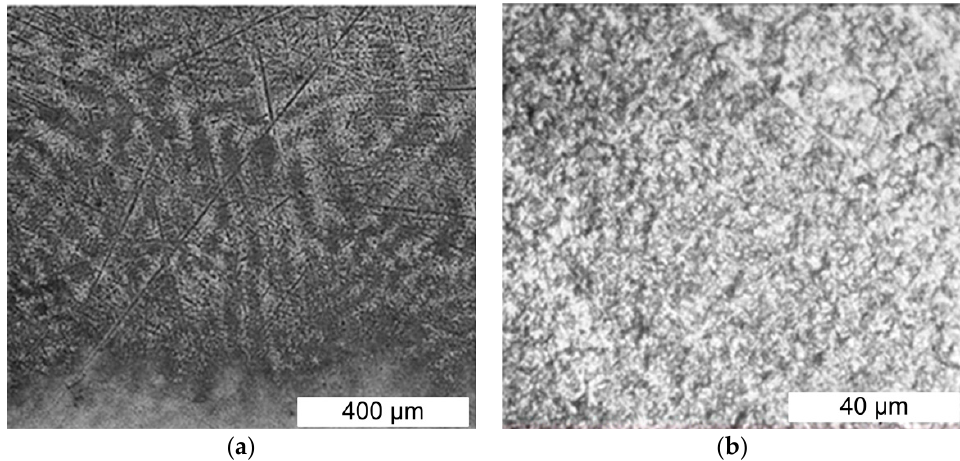
Figure 2. Microphotographs of the Ti-20Nb-10Ta-5Zr surface: ( a ) after fabrication; ( b ) after polishing. Scale bar is represented as a white rectangle. The width of the corresponding rectangle ( μ m) is given inside it.